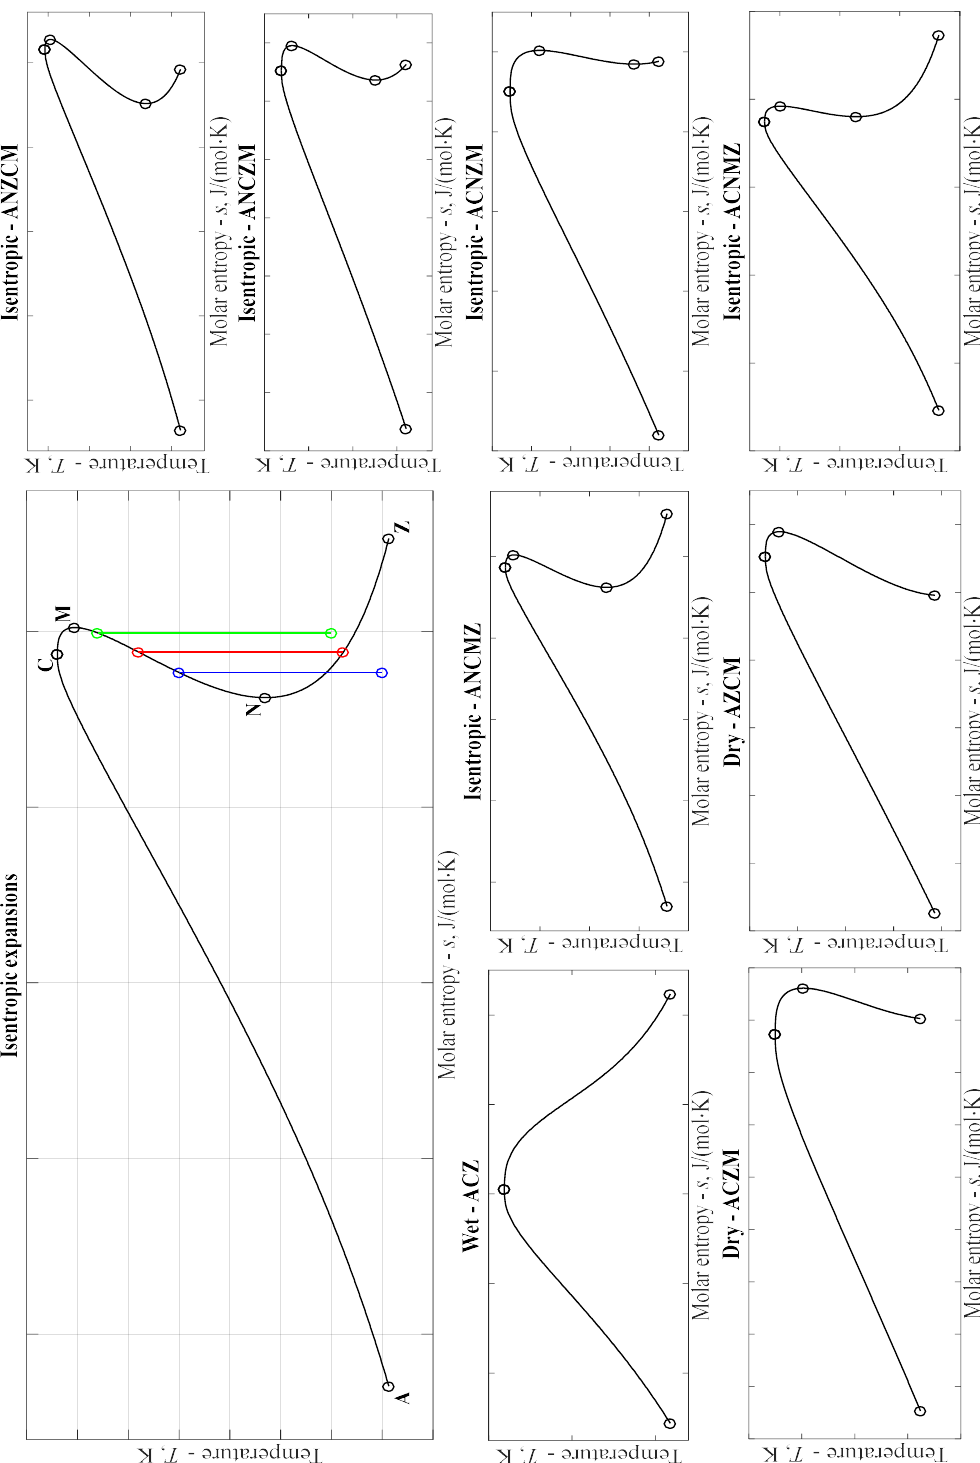
Figure 2. Novel classification: visualization of characteristic points and the novel eight categories (sequences). a detailed description, see corresponding text below or for further details, Reference [18].